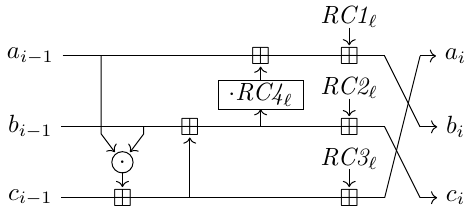
Figure 9: rolling function rol . Figure 10: Ciminion round